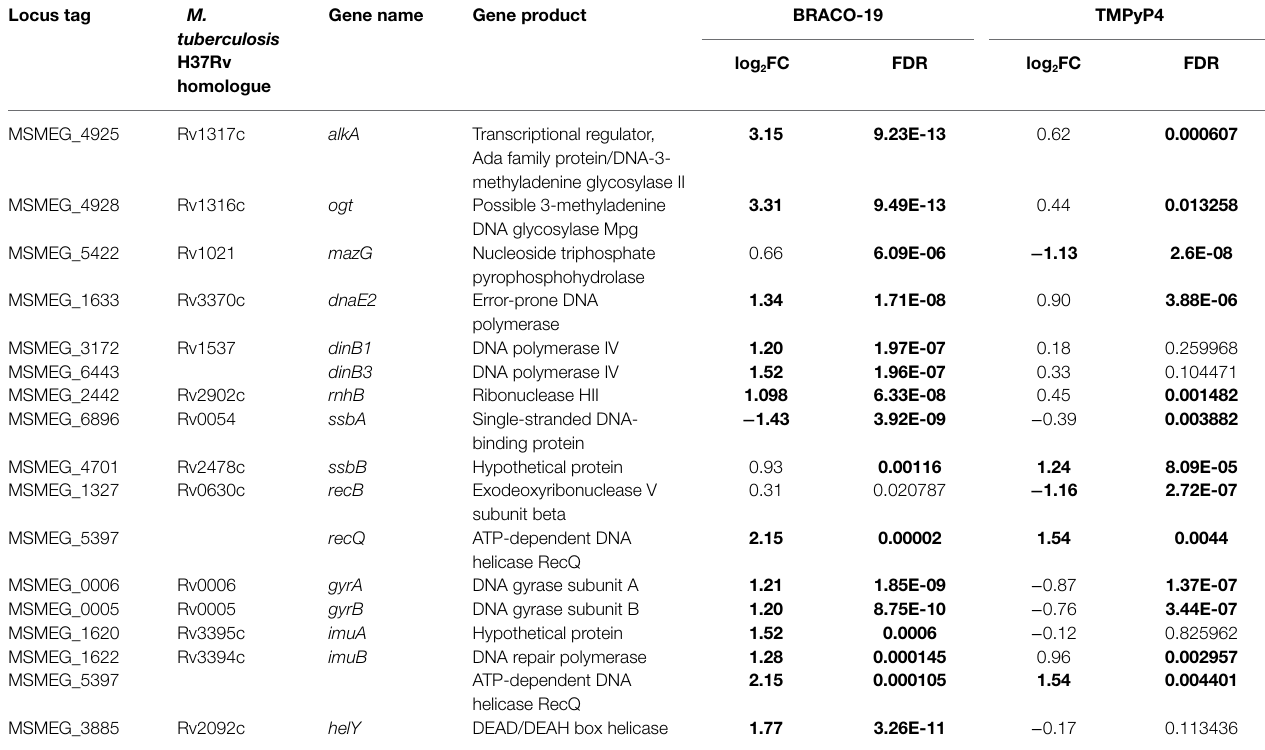
TABLE 1 | Differentially expressed genes of the DNA replication and repair systems in M. smegmatis exposed to BRACO-19 and TMPyP4. Locus tag M.